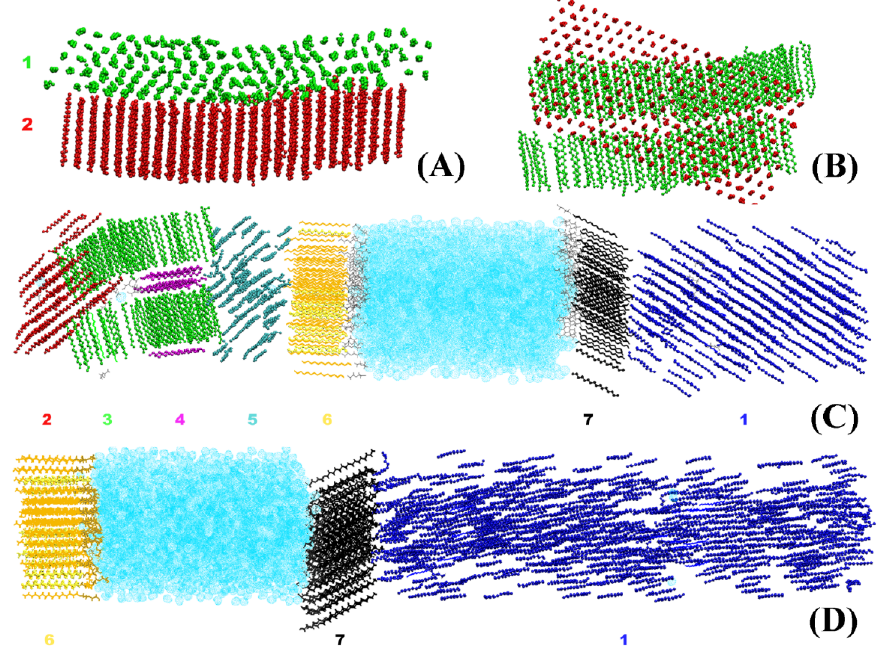
Figure 1. Illustration of the crystallites in the model systems after 500 ns simulation in the solid state: ( A ) side and ( B ) top view of the crystallites in bulk HEX, side view of all crystallites in HEX/Surf/water ( C ) at 278 K and ( D ) at 289 K. Each color represents a separate crystallite, and each crystallite is assigned a number. Hexadecane is represented with beads, the surfactant tails—with thick lines, the surfactant heads—with thin lines, and the water molecules—with bubbles.